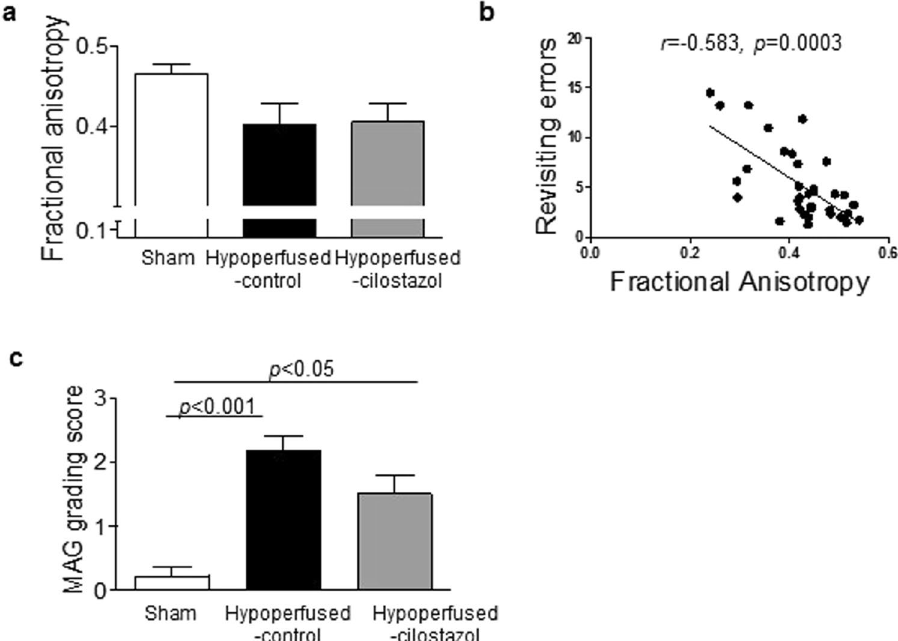
Figure 2. Cilostazol did not significantly restore white matter integrity. ( a ) There was no significant difference in Fractional Anisotropy (FA) in the corpus callosum between the three groups. ( b ) A significant relation between FA and revisiting errors was determined (Spearman r = − 0.583, p = 0.0003). ( c ) MAG grading, as an index of breakdown in axon-glial integrity, was significantly increased after hypoperfusion, but no protective effect of cilostazol could be observed. Data represents mean ± SEM. ** p < 0.001, Hypoperfused-control vs Sham; ** p < 0.05, Hypoperfused-Cilostazol vs